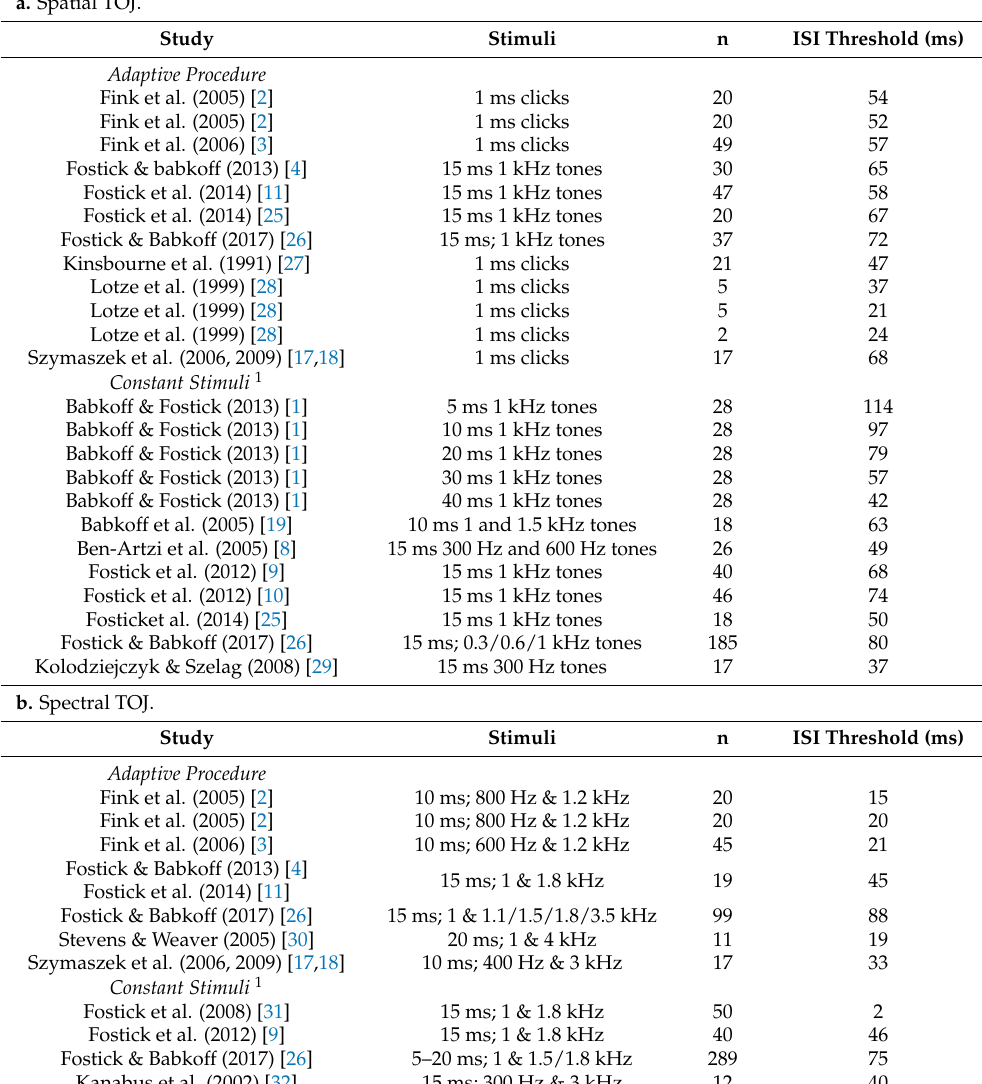
Table 1. Spatial and spectral TOJ thresholds by psychophysical methods. a. Spatial